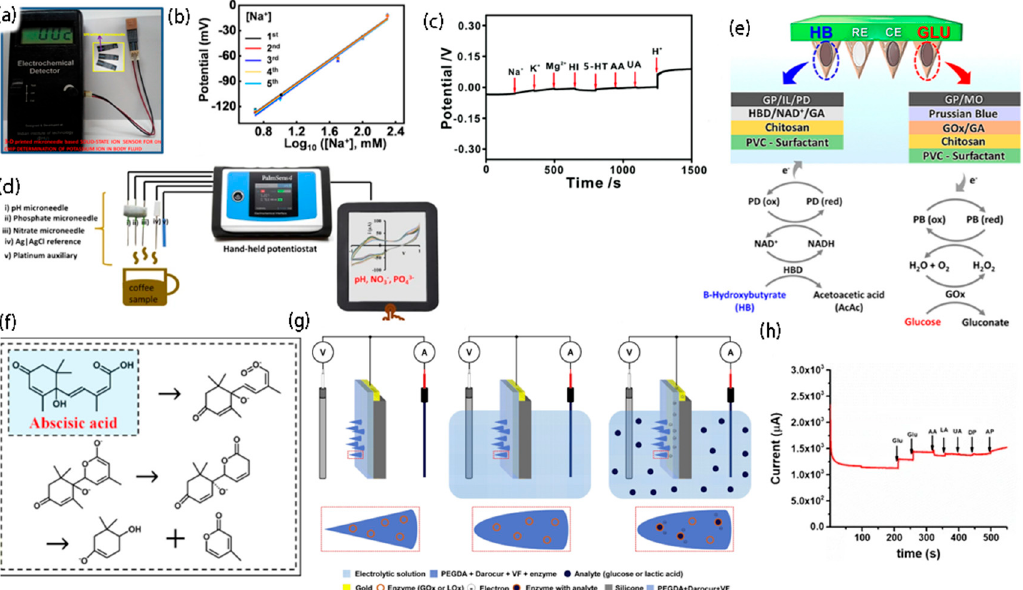
Figure 3. Monitoring of biochemical indicators. ( a ) Microneedle-assembled all − solid − state potassium ion sensor [44]; copyright 2020, Wiley Periodicals LLC. ( b ) The repeatability of the Na+ sensor [38]; copyright 2021, American Chemical Society. ( c ) Selective measurement of MoS 2 /PAN/AN with the addition of a series of interfering substances [45]; copyright 2018, The Royal Society of Chemistry. ( d ) Stainless steel electrochemical capacitance microneedle sensor capable of simultaneously measuring pH value, nitrate, and phosphate [46]; copyright 2021 Springer Nature. ( e ) Schematic representation of dual-marker sensing on a microneedle sensor platform [47], copyright 2020, American Chemical Society. ( f ) Detection mechanism of ABA in plants [48]; copyright 2021 Elsevier. ( g ) Working concept sketch of the three-electrode system [49]; copyright 2016 Elsevier. ( h ) Chronoamperometric response of Au/Pt black/nafion microneedle electrodes with three in the presence of common interfering substances in + 0.12 V buffered saline [50]; copyright 2018, Springer Nature.